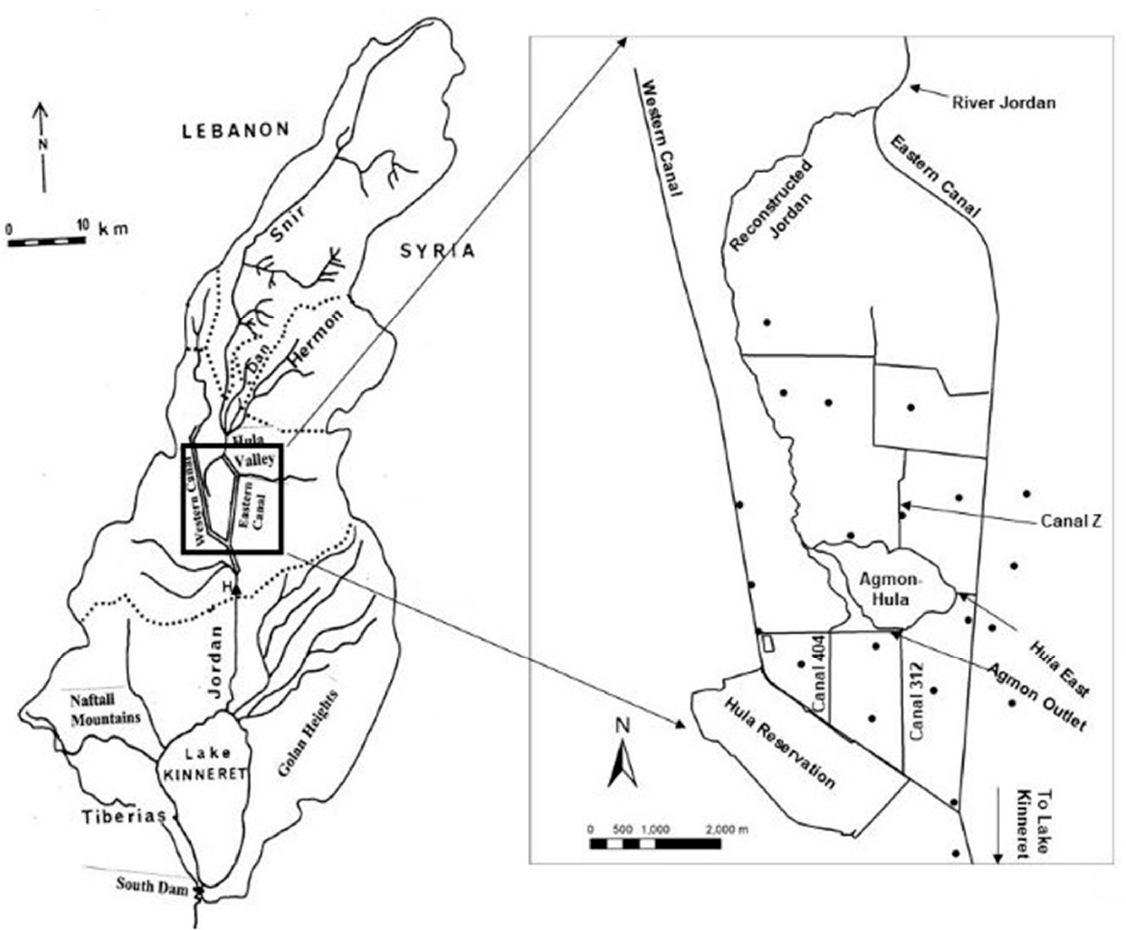
Figure 1. Geographical maps: Kinneret watershed ( left ), Hula Valley ( right ); ground water table sampling bore holes (black points) are indicated. Flow directions from north to south: rivers ( left panel) to lake Kinneret; ( right panel) drainage canals to Lake Agmon-Hula and principal canals to Lake